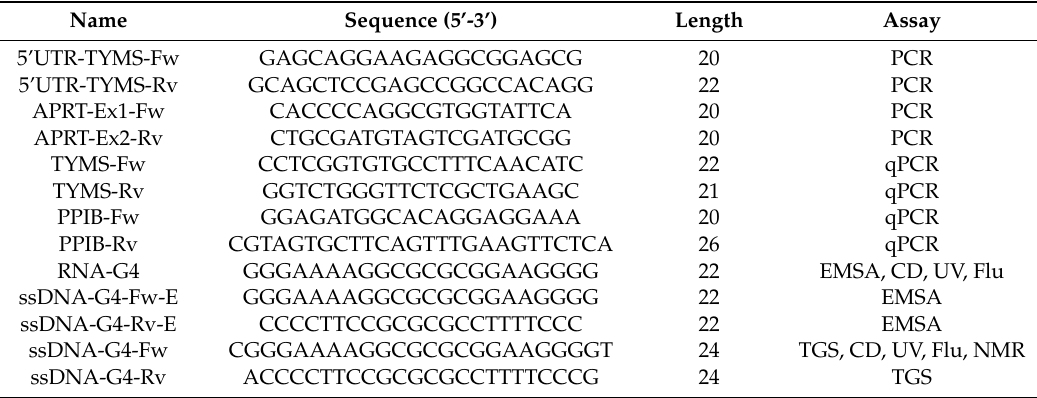
Table 1. Oligonucleotides used in this study.